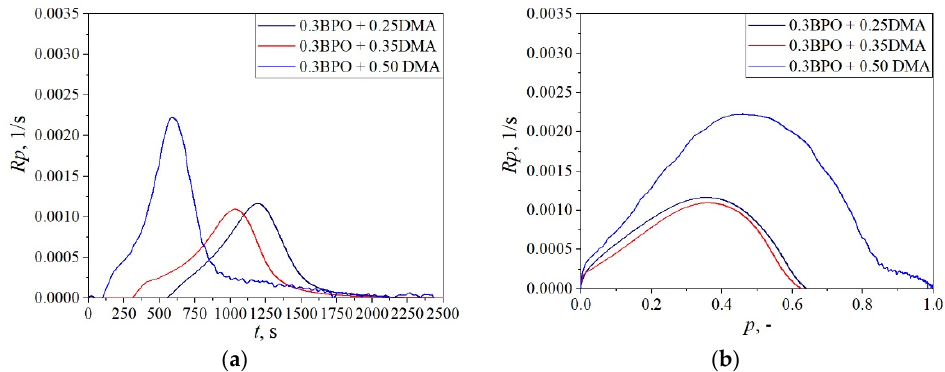
Figure 3. Kinetic curves of polymerization of bone cement compositions containing various amounts of DMA co-initiators and 0.3 wt.% of BPO initiators as a function of polymerization rate ( R p ) from ( a ) reaction time ( t ), and ( b ) double bond conversion ( p ). The concentration of BPO was set as 0.3 wt.%, and for DMA, it was set as 0.25 wt.%, 0.35 wt.% and 0.5 wt.% of monomer mass, which corresponds to approximately 1.7, 2.3 and 3.3 co-initiator molecules per one initiator molecule, respectively.